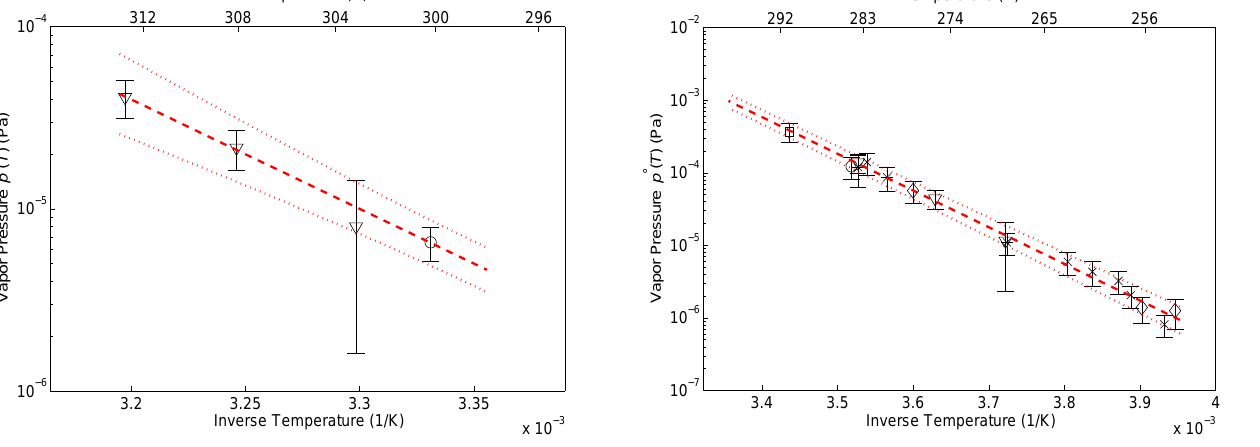
Fig. 5. Pure component vapor pressure p ◦ ,L of 2-methylglutaric acid (open symbols, denoting six different particles). Fit line (dashed) is to Eq. (5) with 2 σ error bounds shown as dotted lines. These data demonstrate that this method produces consistent, high quality data over a broad range of